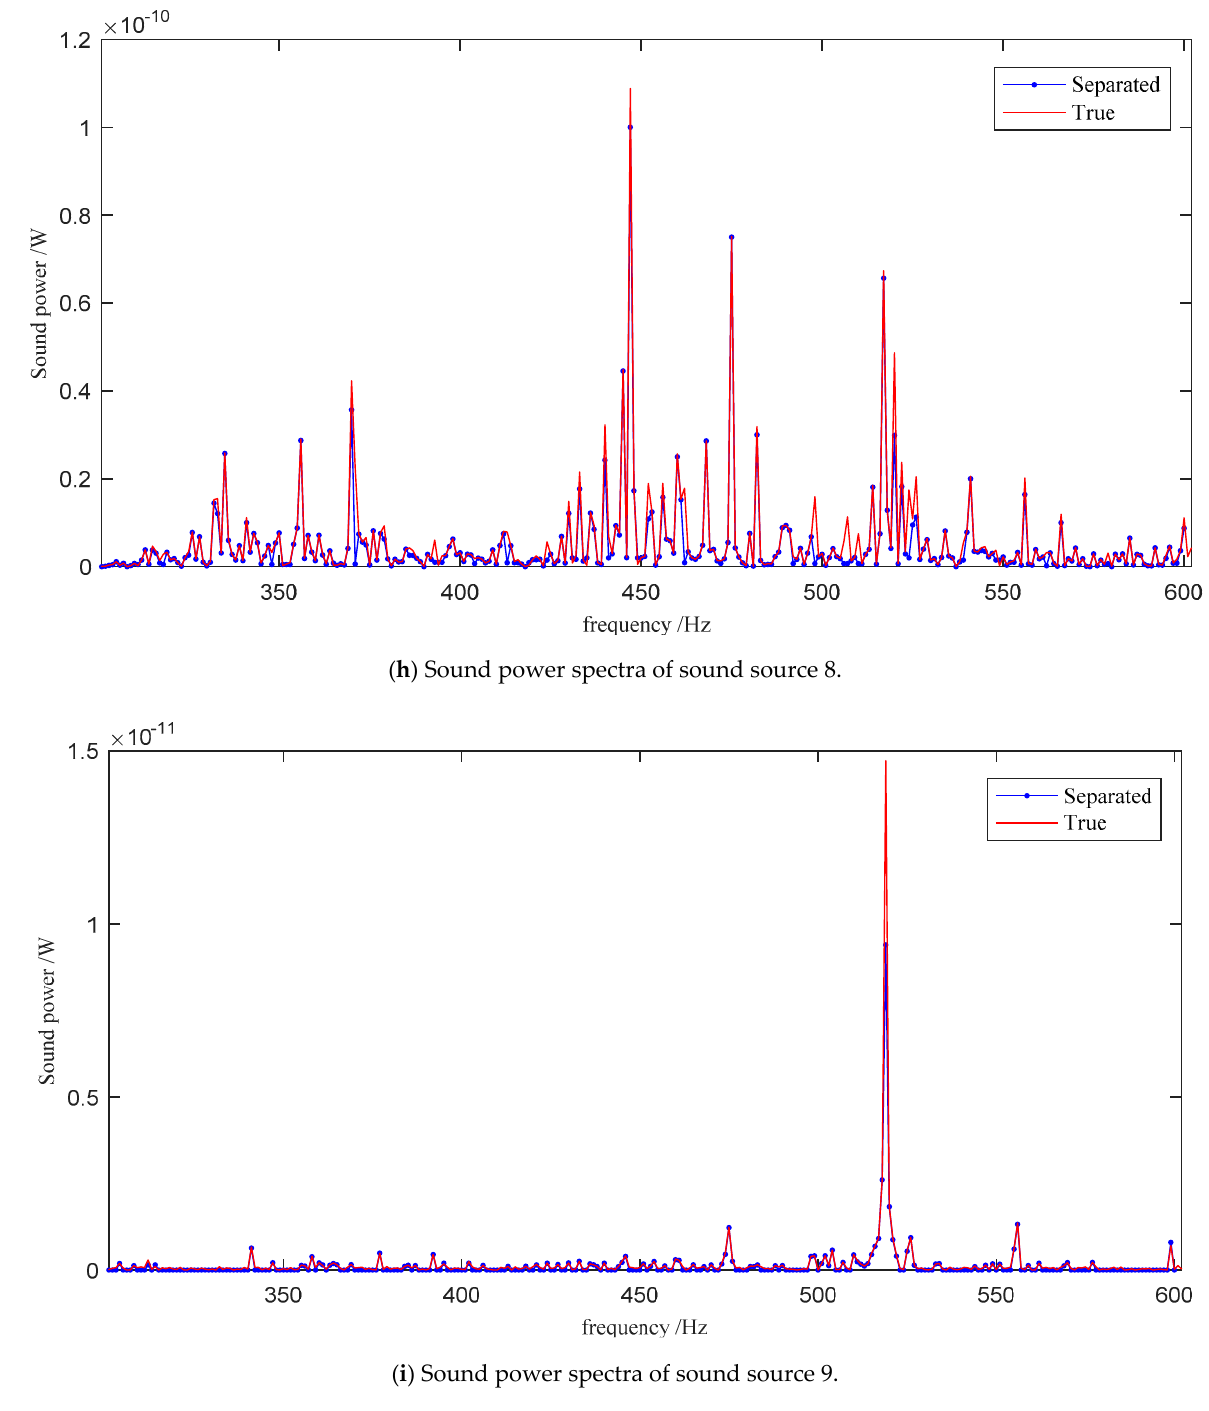
474 Hz. Here, 472 Hz is close to the meshing frequency of the toothed belt. The six